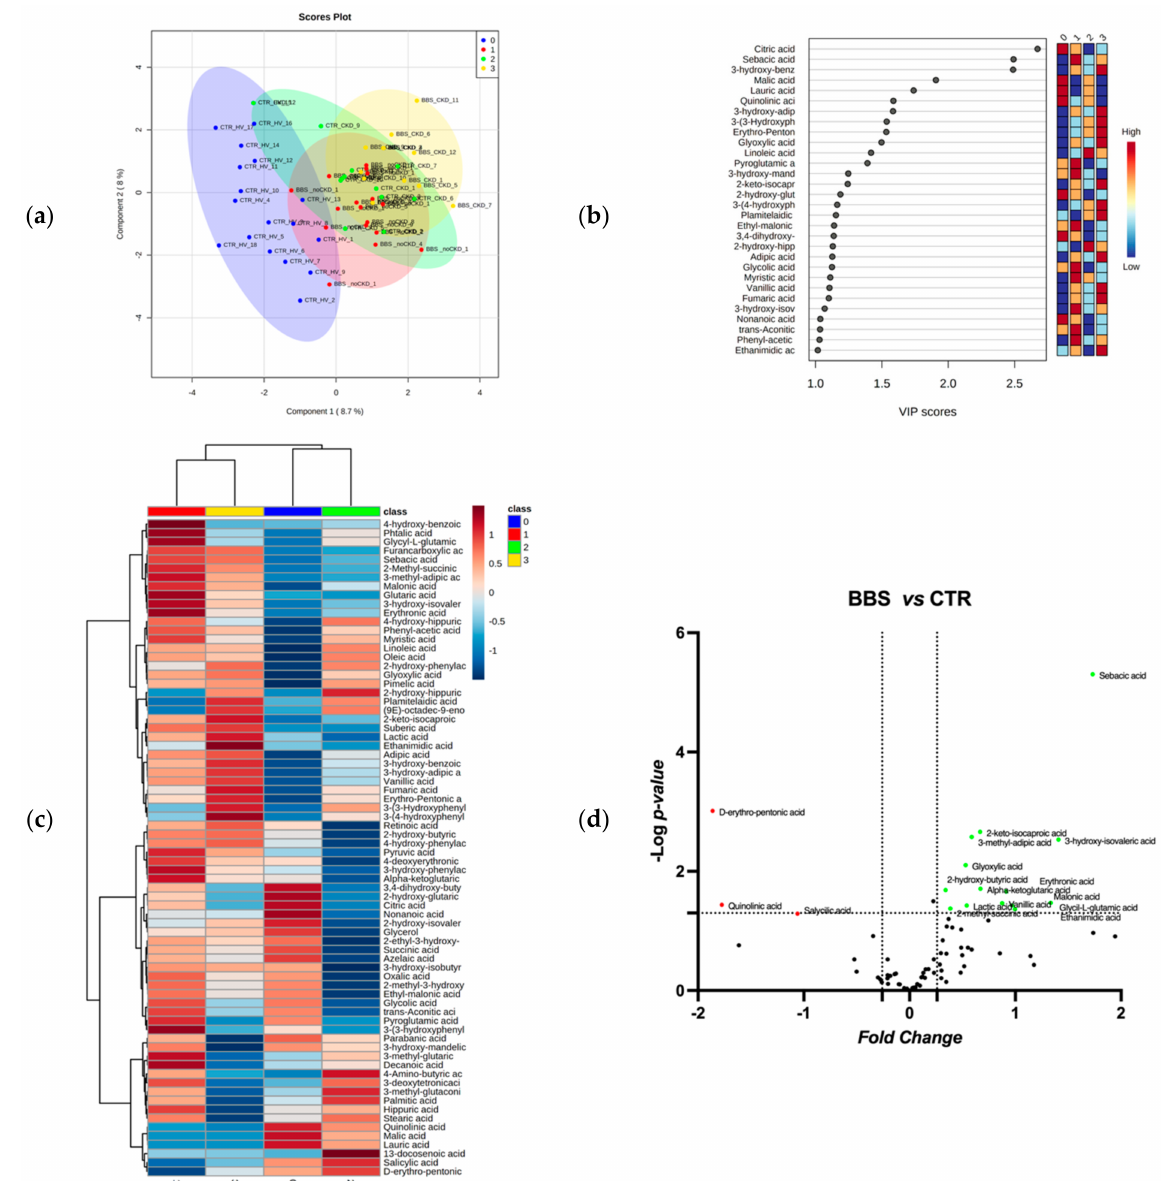
Figure 1. Descriptive discriminant analysis of the urine metabolome of BBS patients. ( a ) The supervised partial least squares-discriminant analysis (PLS-DA) shows the segregation in four- condition analyzed metabolomes, CTR_HV, BBS_noCKD, CTR_CKD, and BBS_CKD, according to component 1, 8.7%, and component 2, 8.0%. ( b ) Discriminant features were identified according to the Variable Importance in Projection (VIP) score. The 30 most important molecules with VIP score values >1.0 are reported. The intensity of the colored boxes represents the relative abundance in each group. The concentrations of the identified metabolites were normalized, log (10) transformed, and Pareto scaled. ( c ) Heatmaps of the average urine metabolite concentrations ( µ M) in each group (0 = CTR_HV, 1 = BBS_noCKD, 2 = CTR_CKD, and 3 = BBS_CKD). The hits were ranked by ANOVA . ( d ) Volcano plot analysis of metabolites significantly different in BBS patients versus controls (BBS, including BBS_noCKD and BBS_CKD, versus CTR, including CTR_HV and CTR_CKD). The relative abundance of each metabolite was plotted against its statistical significance, respectively, reported as Fold Change (log2 fold change) and -log10 ( p -value). Red and green dots indicate features that presented a p -value < 0.05 and a Fold Change < − 1.3 or >1.3, respectively. Black dots refer to all the metabolites identified in the dataset whose relative abundance is not significantly different between BBS patients and healthy